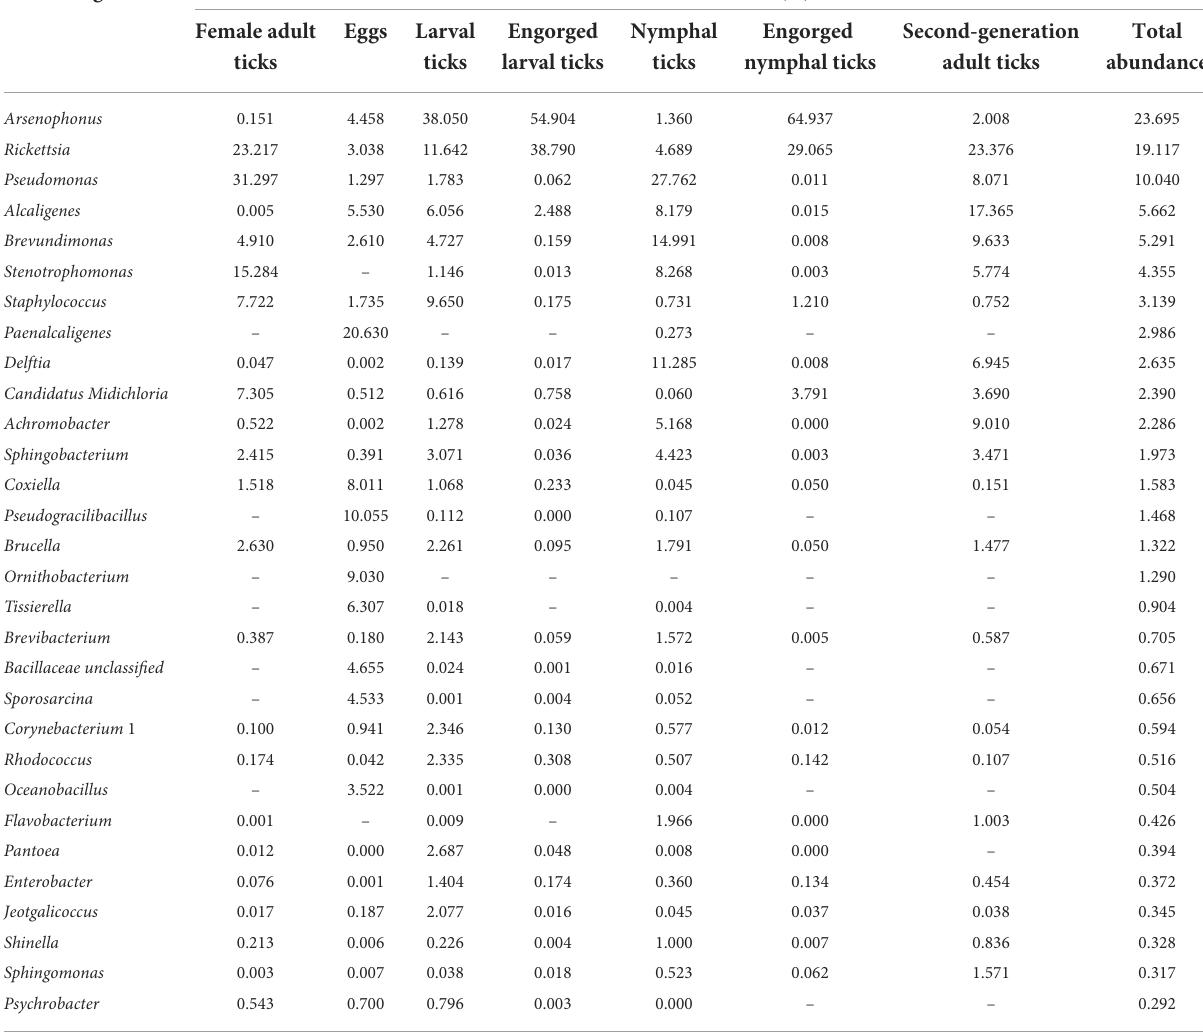
TABLE 5 The relative abundance of 30 bacterial genera in the 7 samples. Bacterial genus Relative abundance (%) Female adult Eggs Larval Engorged Nymphal Engorged Second-generation Total ticks ticks larval ticks ticks nymphal ticks adult ticks